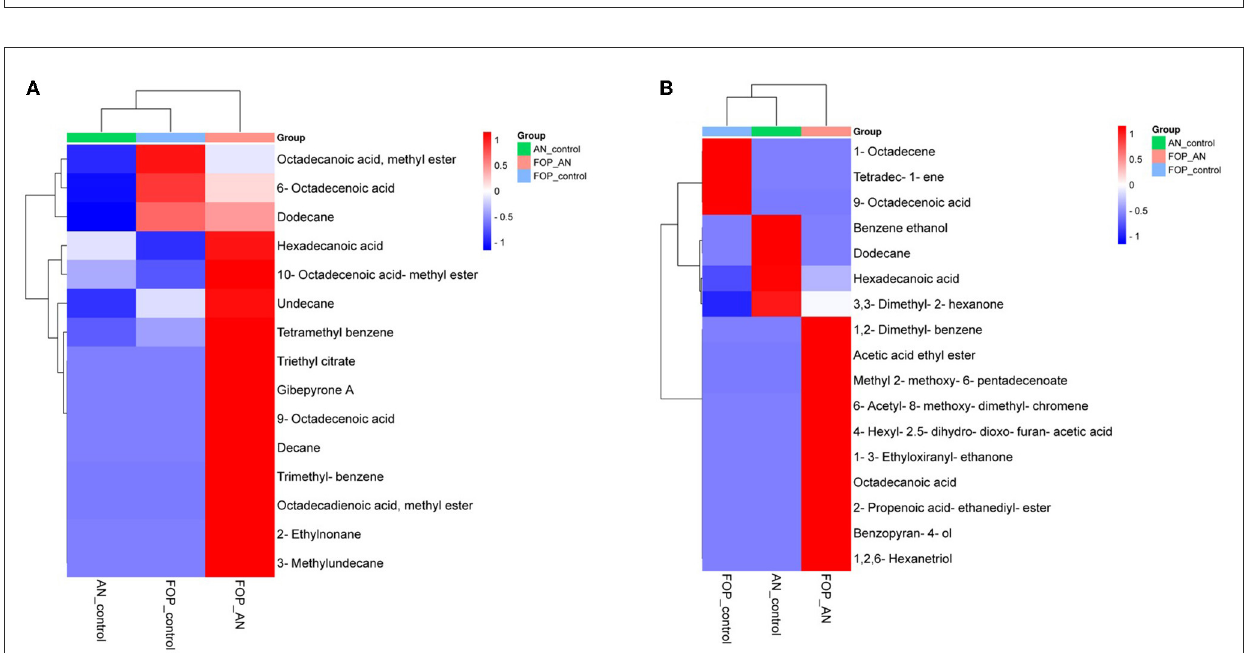
FIGURE9 Heat map clustering of volatile organic compounds (VOCs) profiles from A. niger (AN) and F. oxysporum f. sp. psidii (FOP) and their interactions in (A) hexane and (B) ethyl acetate fractions.